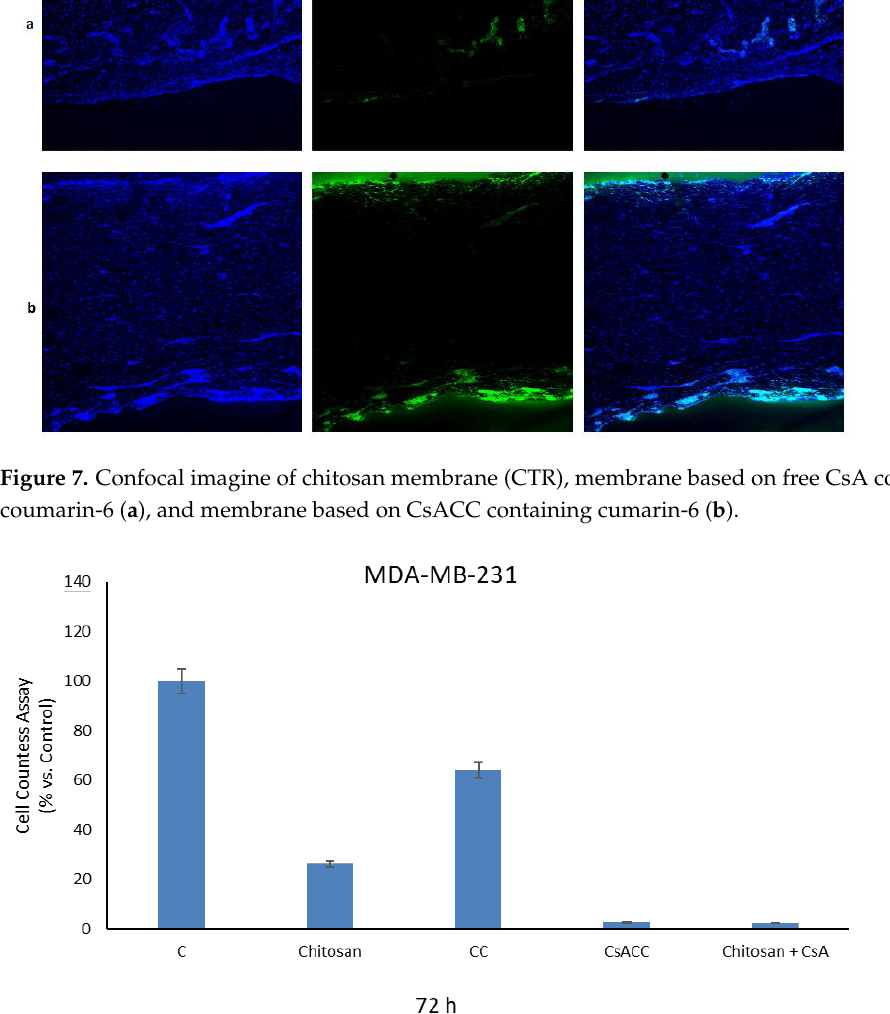
Figure 8. Cell proliferation assay on MDA-MB-231 cell lines of chitosan membranes with and without CsA.